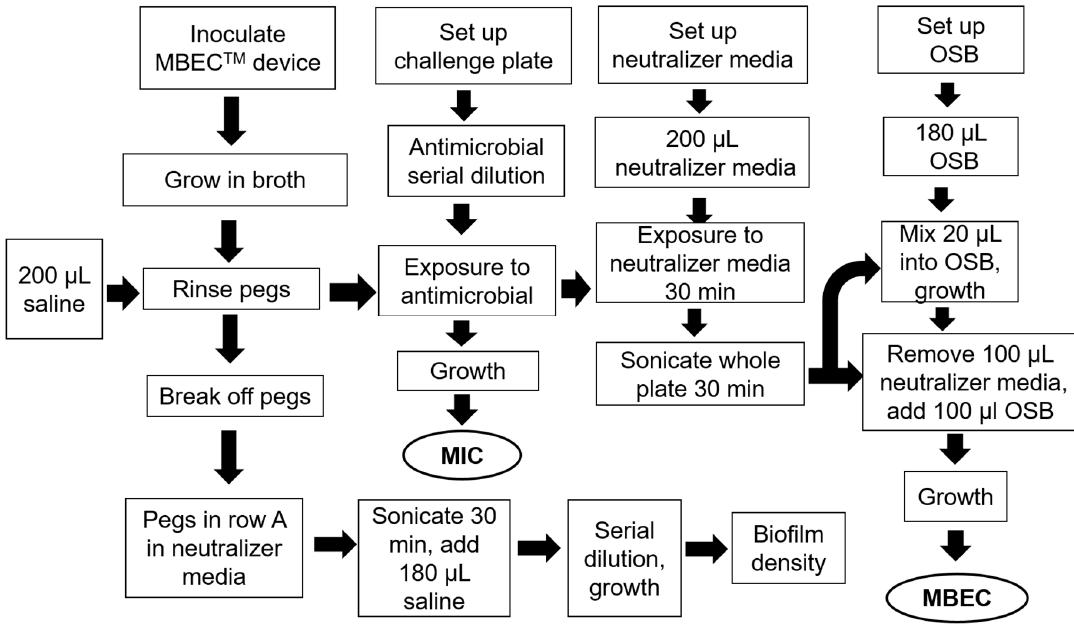
Figure 1. Schematic representation of the high throughput in vitro antimicrobial testing model to evaluate e ffi cacy of cotrimoxazole (sulfmethoxazole and trimethoprim) and neomycin, estimated via the MIC and MBEC values against A. hydrophila and C. portucalensis . OSB refers to organism specific broth; in this work trypticase soy broth (TSB) was used.